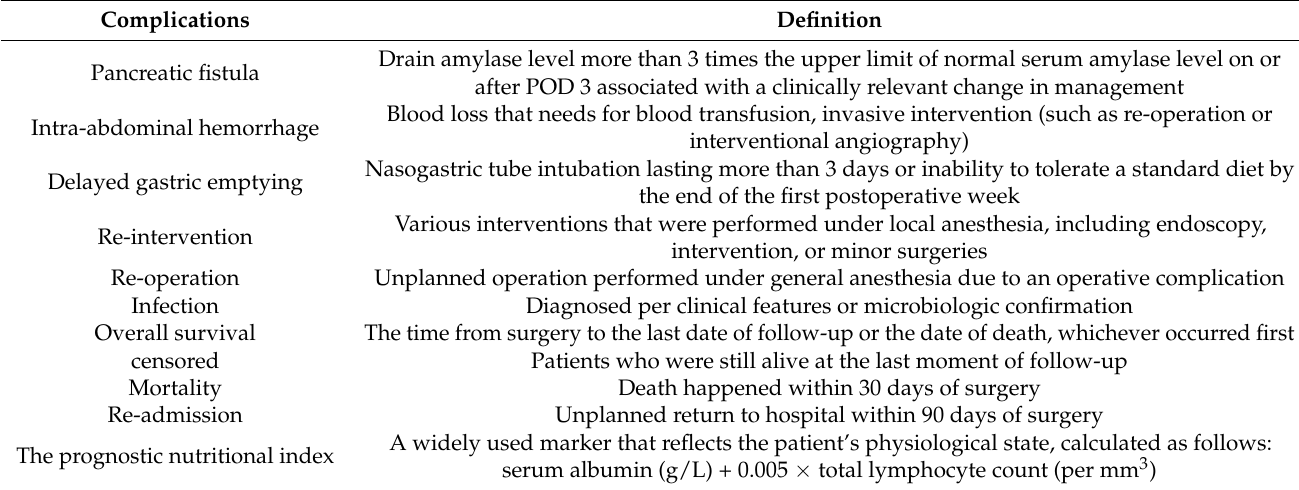
Table A1. Definitions of the post-operative complications.